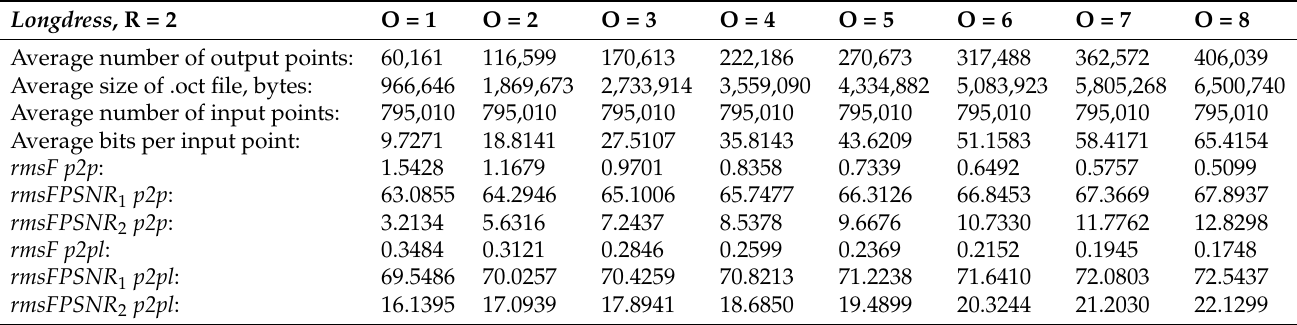
Table 12. Octree reduction using 3DTK toolkit, with voxel size “R” = 2 and different parameters for